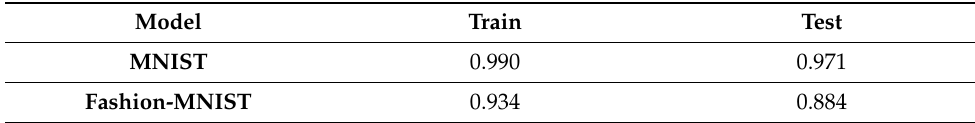
Table 3. Baseline accuracy of target